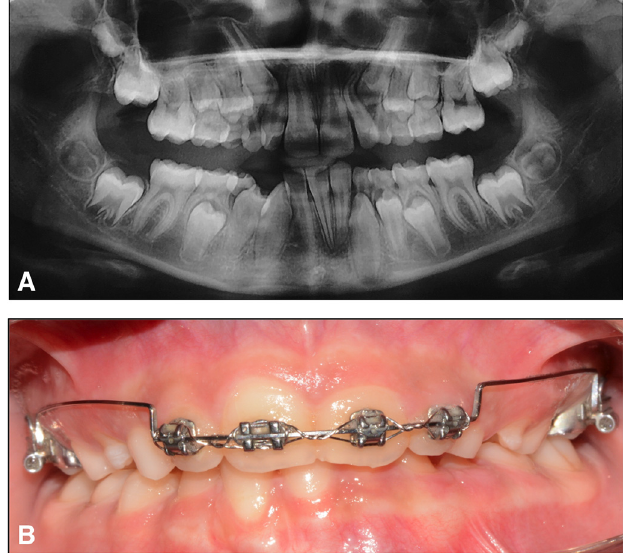
Fig. 7. (A) Panoramic X-ray 24 month after the surgery. (B) Intraoral clinical